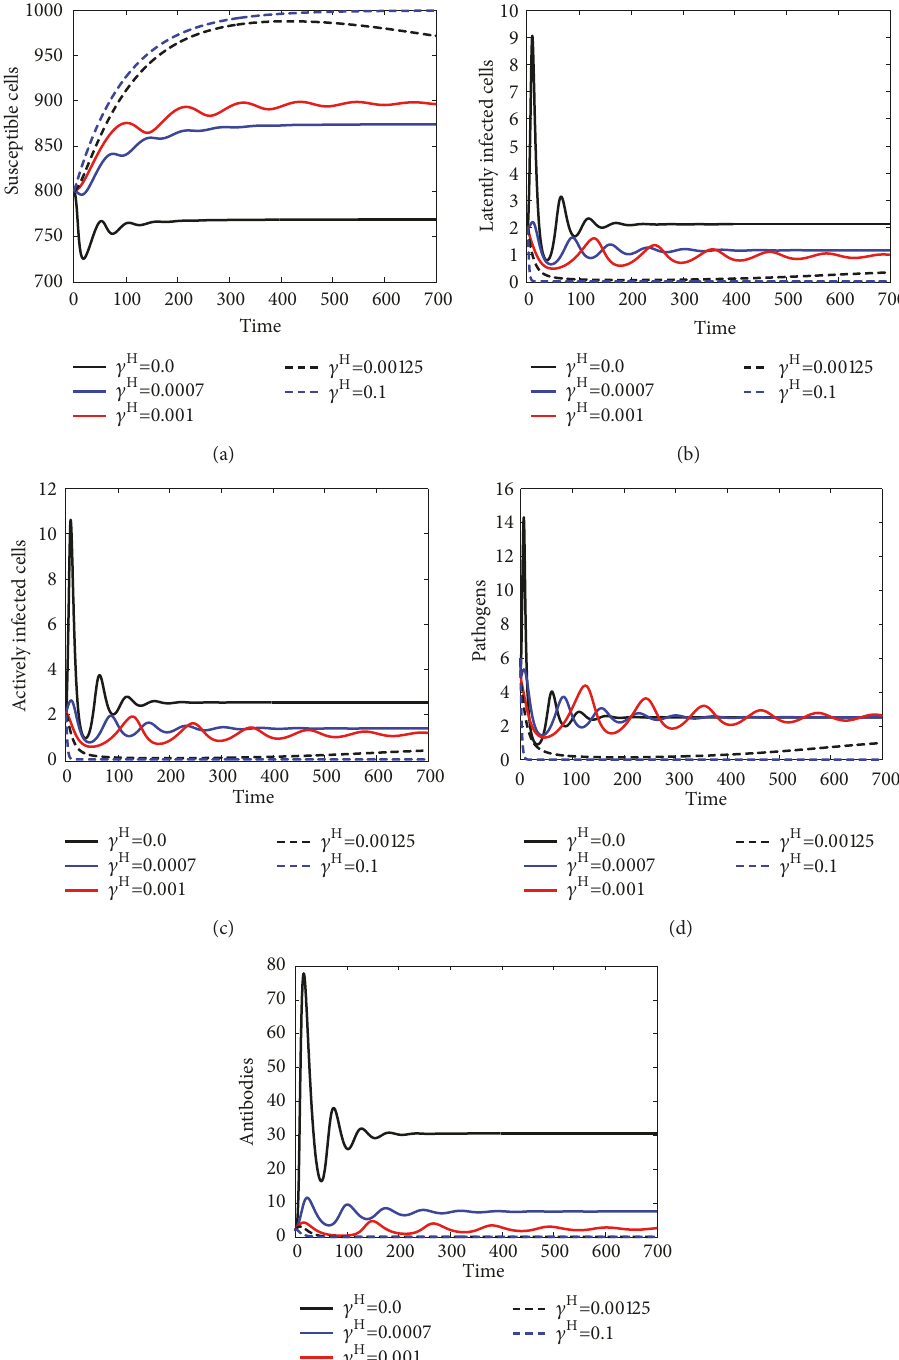
Figure 2: The evolution of system (69)-(73) with different values of 𝛾 𝐻 for Case